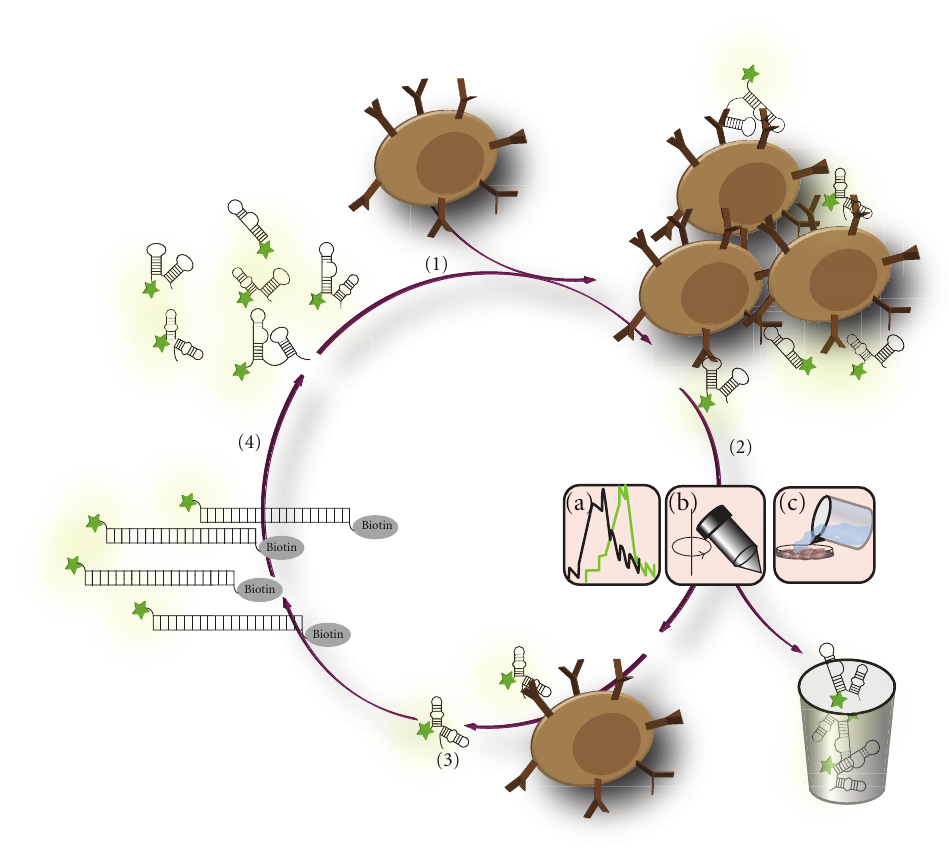
Figure 1: Cell-SELEX. (1) Target cells are incubated with a complex library consisting of up to 10 15 individual single stranded DNA molecules (ssDNA). (2) The separation of cell-binding nucleic acids from nonbinding species can be performed by di ff erent methods: FACS (2a), centrifugation (2b) or washing (rinsing) steps (2c), respectively. (3) Cell-binding DNA molecules—aptamers—are eluted and (4) subsequently amplified by PCR using two specific primers. The 5 (cid:2) -end of the reverse primer carries a biotin. Additionally, a fluorescently labeled forward primer is used for PCR, if FACS is used for separation. After strand displacement the enriched DNA library is used for further selection rounds. This cell-SELEX procedure ends up with aptamers that bind specifically to the surface of target cells.